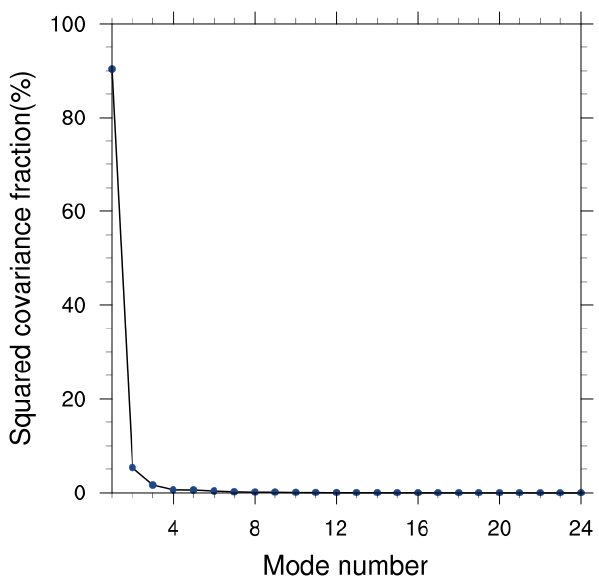
Figure 4. Variance contributions of the first 24 modes from the MEOF analysis of T.